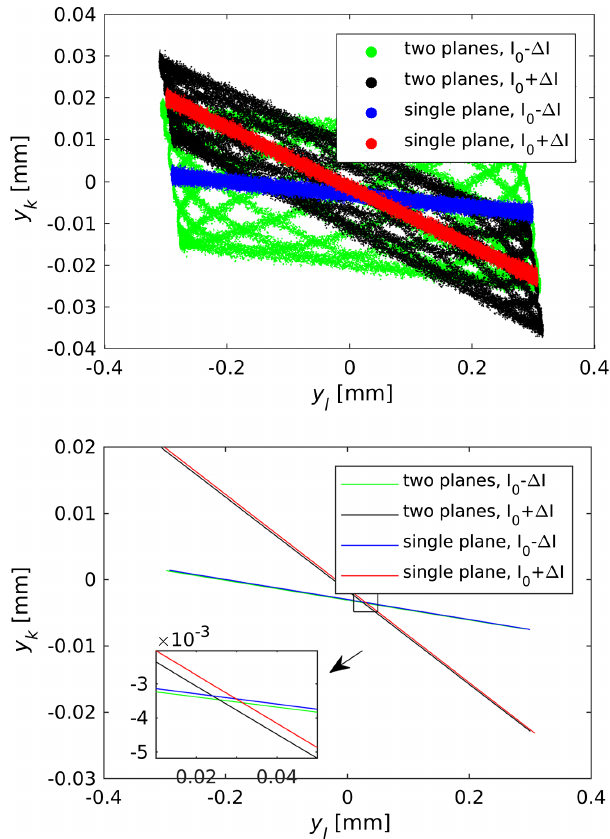
FIG. 4. Top plot: correlation between two BPMs vertical raw data sampled at 10 kHz before (green dots) and after (black dots) a quadrupole change during the simultaneous excitation of a horizontal (at 7 Hz) and a vertical (at 6 Hz) OCM. Blue and red dots correspond to data taken with one OCM at a time. Bottom plot: comparison between the lines resulting from fitting the single-frequency case with Eq. (2) and those of Eqs. (6) and (8) from the dual-frequency case. The two final offsets agree roughly: 32 (cid:2) 4 μ m from the single-frequency excitation and 29 (cid:2) 2 μ m from the dual-plane modulation. The data shown here corresponds to the case BPM l ¼ 5